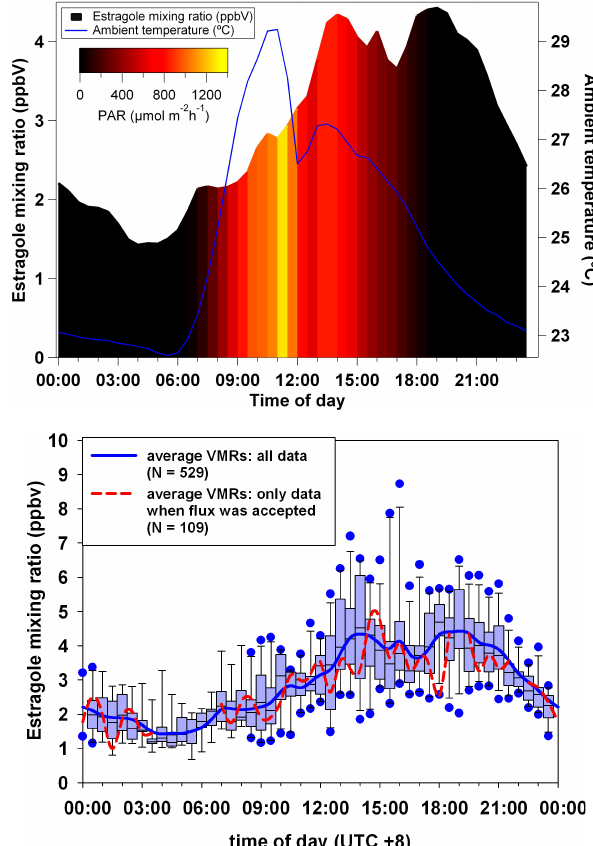
Fig. 4. Average diurnal cycles of estragole mixing ratios (left axis): (a) average in relation to temperature (right axis) and PAR (colour scale); (b) Box-and-Whisker plot of day-to-day variability, showing averages (blue line), median with 25th and 75th percentile (box), 5th and 95th percentiles (whiskers) and outliers (dots).